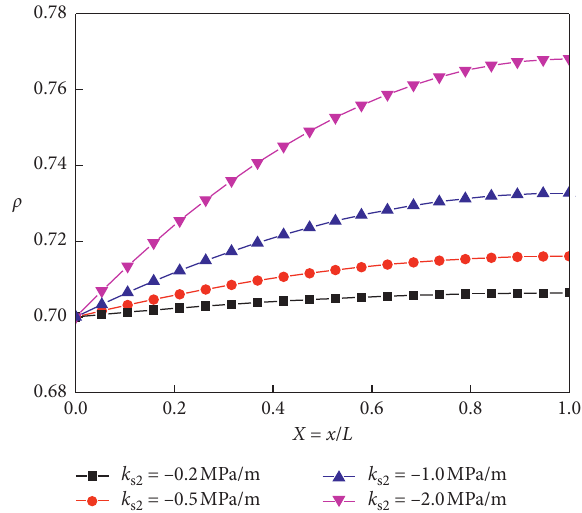
Figure 24: Effect of the interface frictional resistance at stage III on k s 2